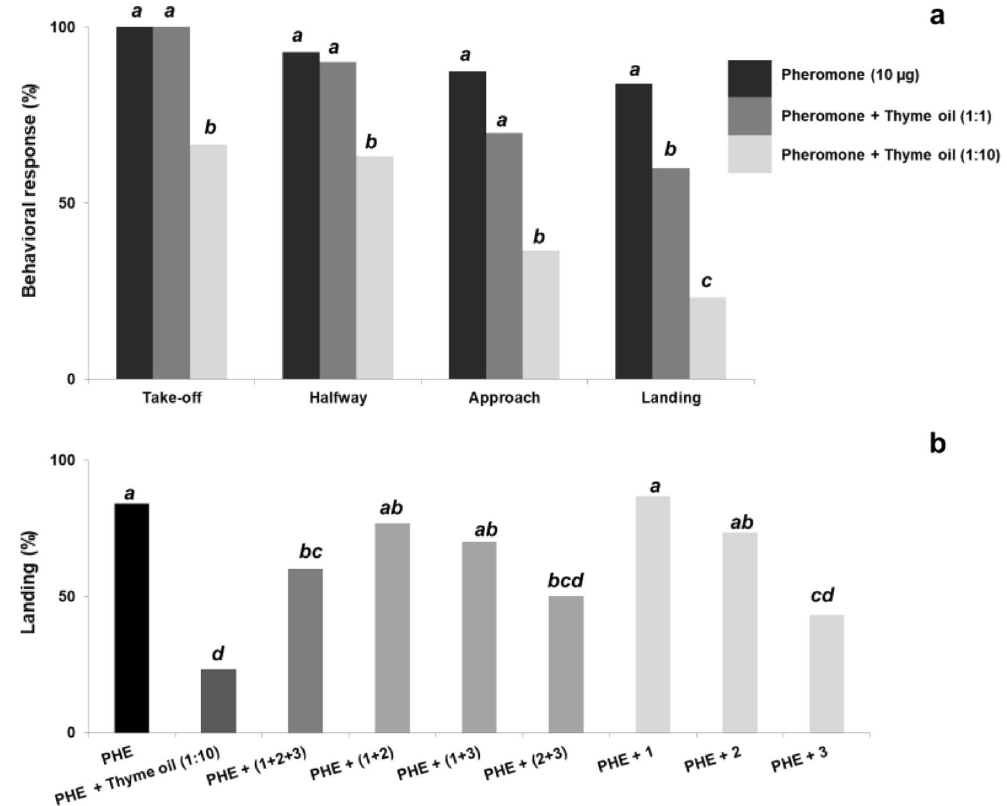
Figure 5. Sequential behavioral steps of S. littoralis males in response to the sex pheromone alone (PHE: Z 9 E 11-14:OAc, 10 µg) (n = 56), or co-released with thyme oil at 1:1 and 1:10 ratios (n = 30) ( a ); Landing percentage of males subjected to mixtures of pheromone + thyme oil (1:10), PHE + p -cymene (30 µg) ( 1 ), PHE + carvacrol (3 µg) ( 2 ), PHE + thymol (45 µg) ( 3 ), and PHE + binary/ternary blends of thyme oil components (n = 30 for each test) ( b ). Bars with different letters are significantly different (Chi-square 2 × 2 test of independence with Yates’ correction, at α =